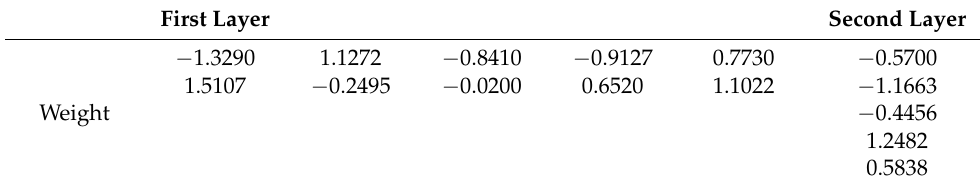
Figure 10. Comparison of the frost heave ratio and its predicted value as obtained by the ANN. Table 4. Weighs and biases of the trained ANN model.